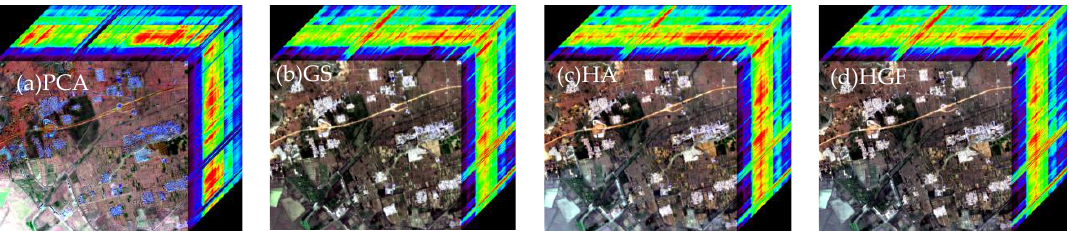
Figure 4. Fused images obtained using ( a ) PCA, ( b ) GS transform, ( c ) HA, and ( d ) HGF processing.